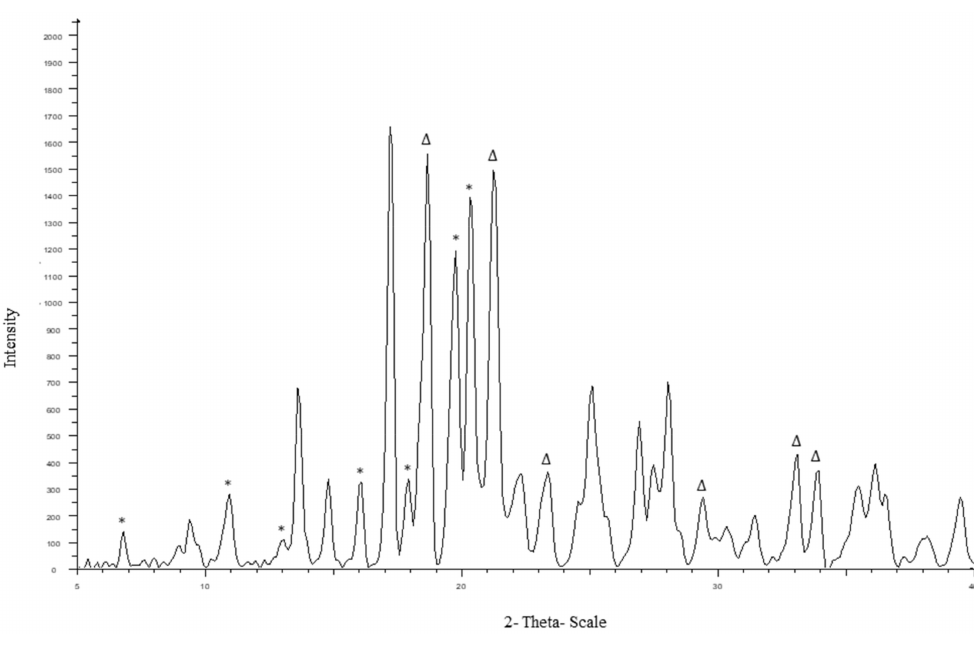
Figure 3. Powder X-ray di ff raction (PXRD) pattern of CEL_NCSD showing characteristic peaks of CEL and MAN. Peaks for CEL and MAN are highlighted in * and ∆ , respectively.